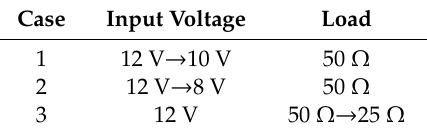
Table 2. Di ff erent cases.